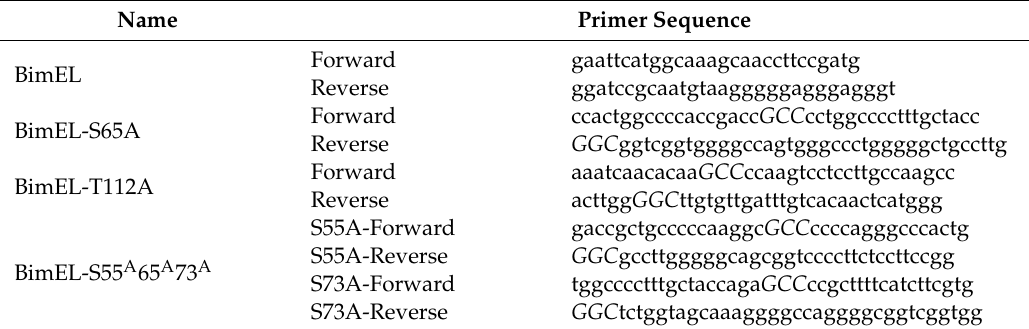
Table 1. Primers used to amplify pig BimEL and BimEL